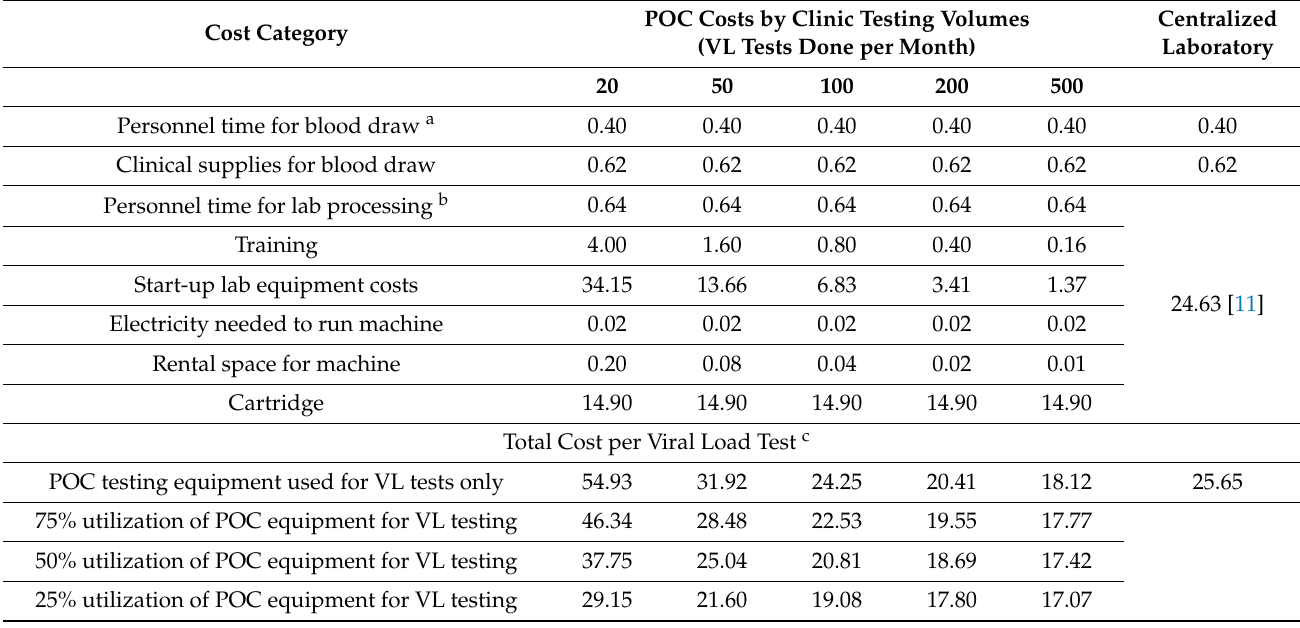
Table 1. Per-test cost of HIV viral load (VL) testing performed as point-of-care (POC) at varying testing volumes and at centralized laboratory facilities in Kenya (2020 USD).